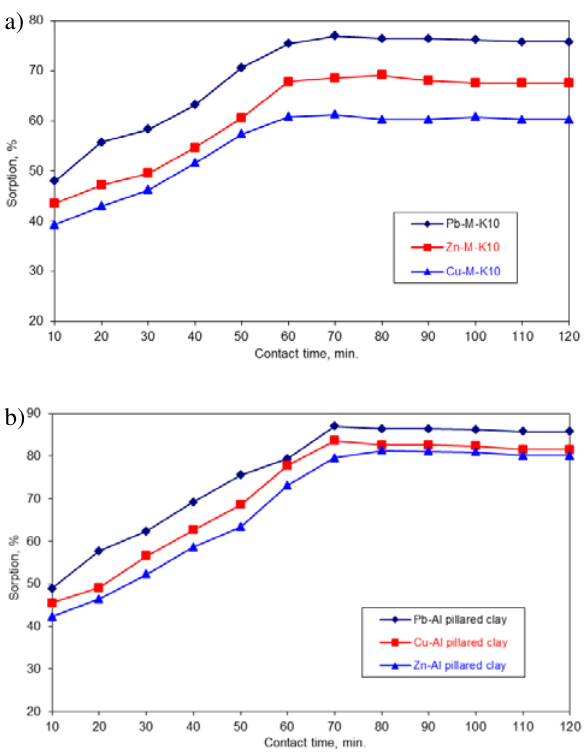
Fig. 1. Effect of contact time on Pb 2+ , Cu 2+ and Zn 2+ adsorption onto montmorillonite-K10 (a) and Al-pillared clay (b); V = 50 mL, m = 0.05g.